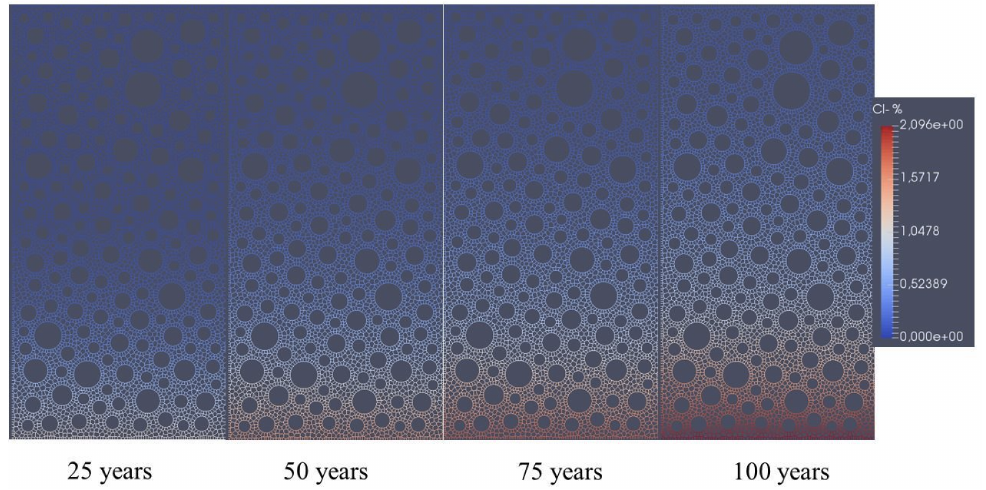
Fig. 8. Chloride distribution within the sample